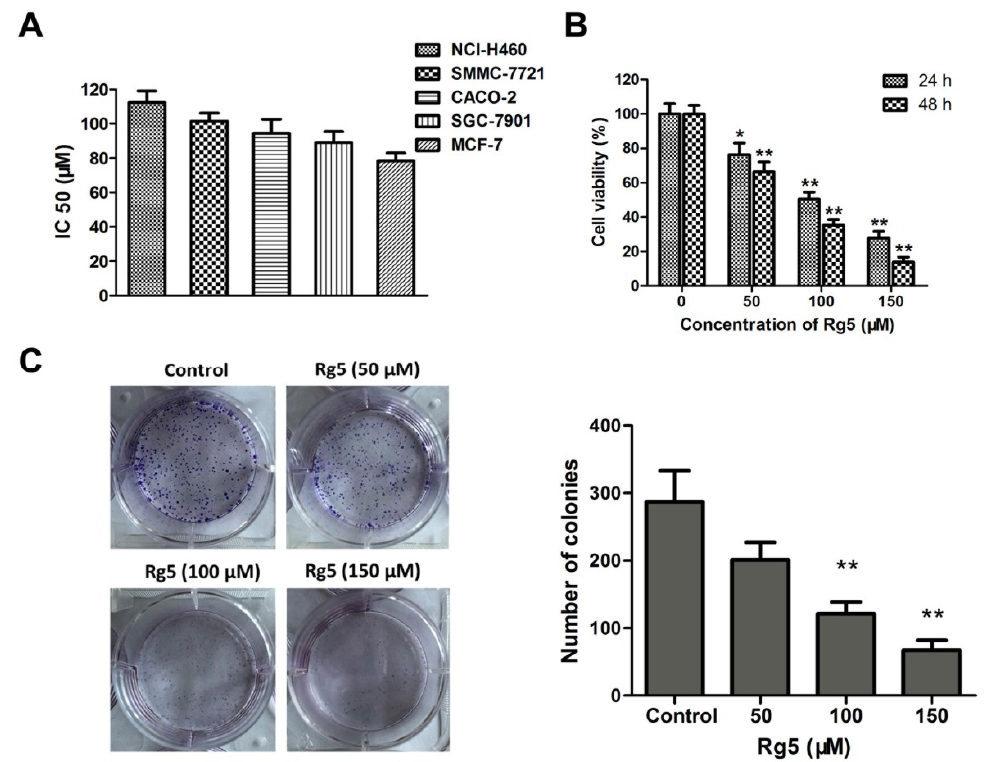
Figure 3. Rg5 suppresses cell viability and colony formation in human breast cancer cells. ( A ) The IC50 values of Rg5 after 48 h treatment were determined in NCI-H460, SMMC-7721, CACO-2, SGC-7901, and MCF-7 cells. ( B ) MCF-7 cells were incubated with Rg5 at di ff erent doses (0, 50, 100, and 150 µ M) for 24 h and 48 h. Cell viability was detected via MTT assay. ( C ) Colony formation assay of MCF-7 cells with control or Rg5. * p < 0.05 and ** p < 0.01 as compared with the control group.